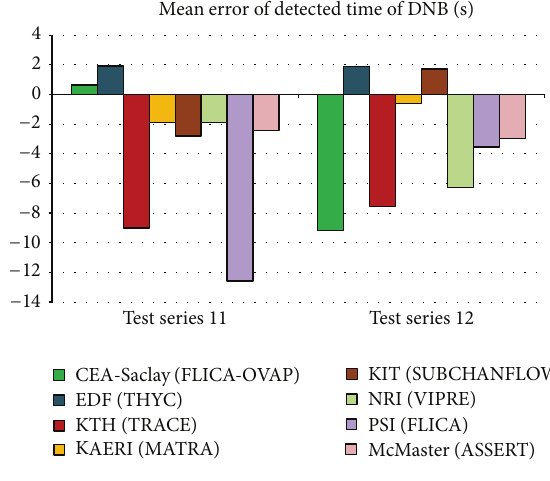
Figure 33: Mean error of detected time of DNB.